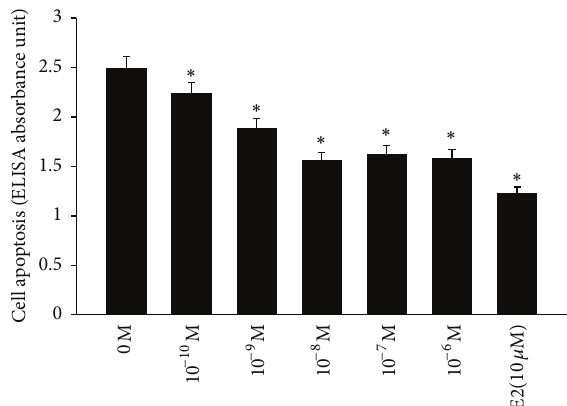
Figure 1: Puerarin protected the hOBs from serum-free-induced apoptosis. Cells were treated with 0–10 −6 M puerarin, and cells exposed to 10 𝜇 M E2 served as the positive control. Apoptosis were measured by ELISA according to the kit specification. The bars represent the mean ± SD ( 𝑛 = 6 ), ∗ 𝑃 < 0.05 , as compared with the control cells.